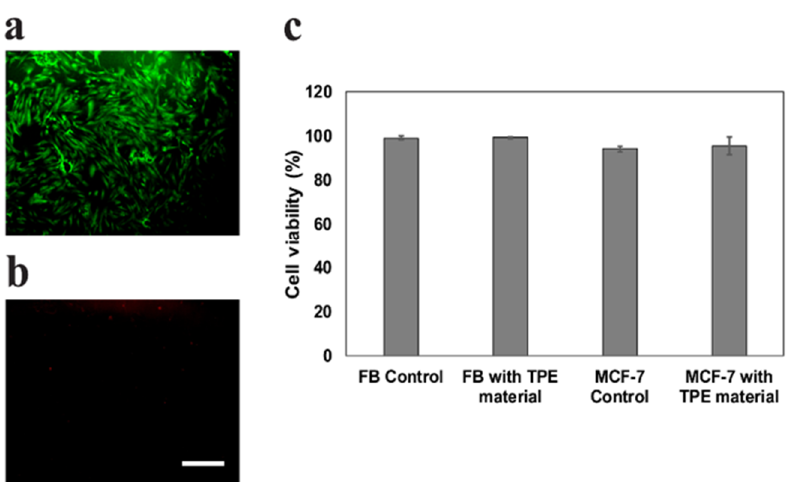
Figure 6. Cell viability test. Representative images of live ( a ) and dead ( b ) fibroblasts cell images. The cell cytotoxicity assay is performed using LIVE/DEAD Cell Imaging Kit. ( c ) A portion of a TPE plug is submerged in cell culture media to examine the release of toxic chemicals from the as-fabricated TPE materials. There is no significant difference of the cell viability for both fibroblasts and breast cancer cells compare to the control groups—no TPE plugs are submerged in culture media.